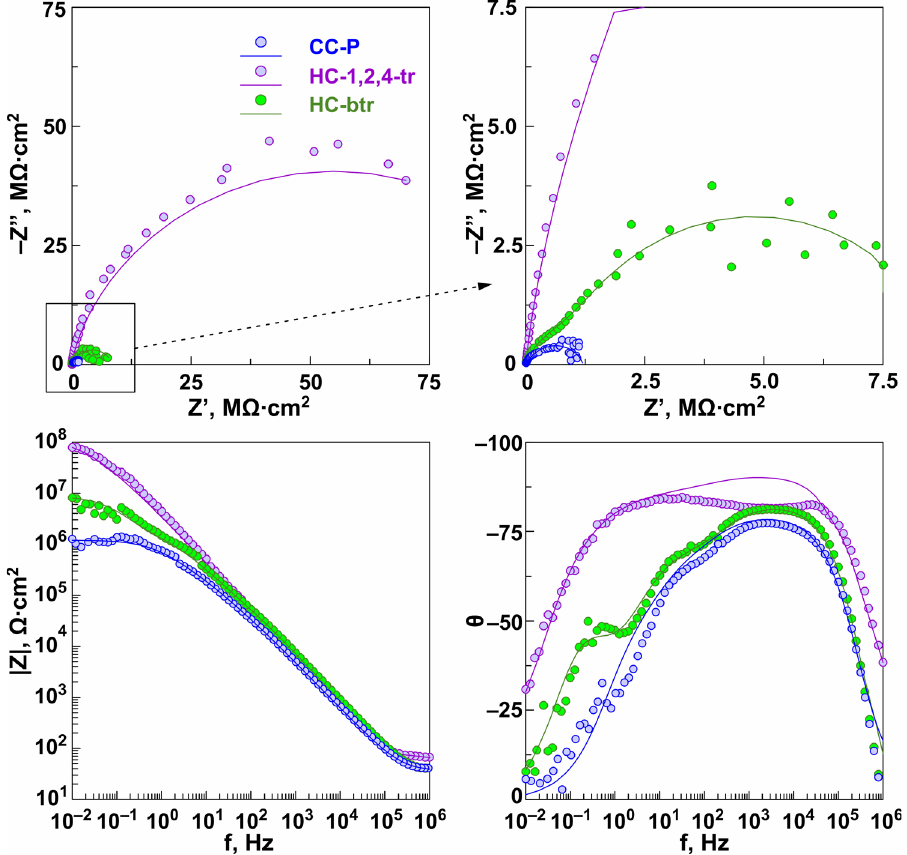
Figure 11. Nyquist and Bode plots for the HC - 1,2,4 - tr and HC - btr samples after 1 h exposure to 3.5 wt.% NaCl solution . T able 4. The calculated parameters of EEC elements for samples of AlMg3 aluminum alloy with various types of HC formed on the basis of a PEO -